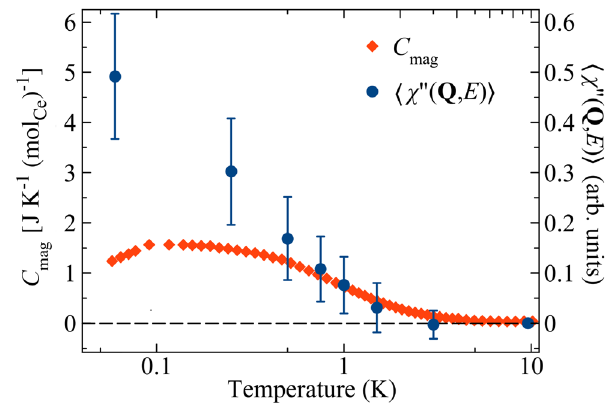
FIG. 16. The low energy dynamic susceptibility χ 00 ð Q ; E Þ , averaged over j Q j ¼ ½ 0 . 46 ; 0 . 93 (cid:2) Å − 1 and E ¼ ½ 0 ; 0 . 15 (cid:2) meV, is plotted alongside the measured C of the present